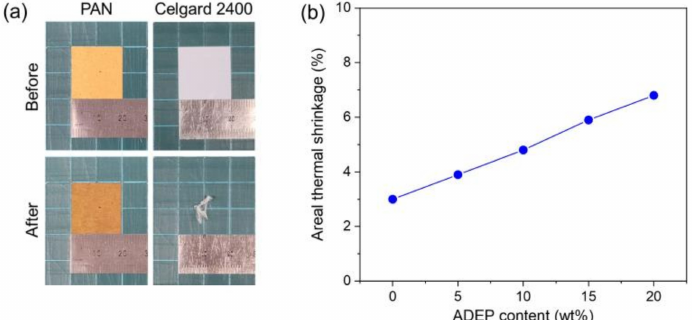
Figure 2. ( a ) Digital photographs of the PAN and Celgard 2400 membranes before and after thermal exposure in air at 200 ◦ C for 1 h; ( b ) the areal thermal shrinkages of the PAN membranes as a function of the content of ADEP.